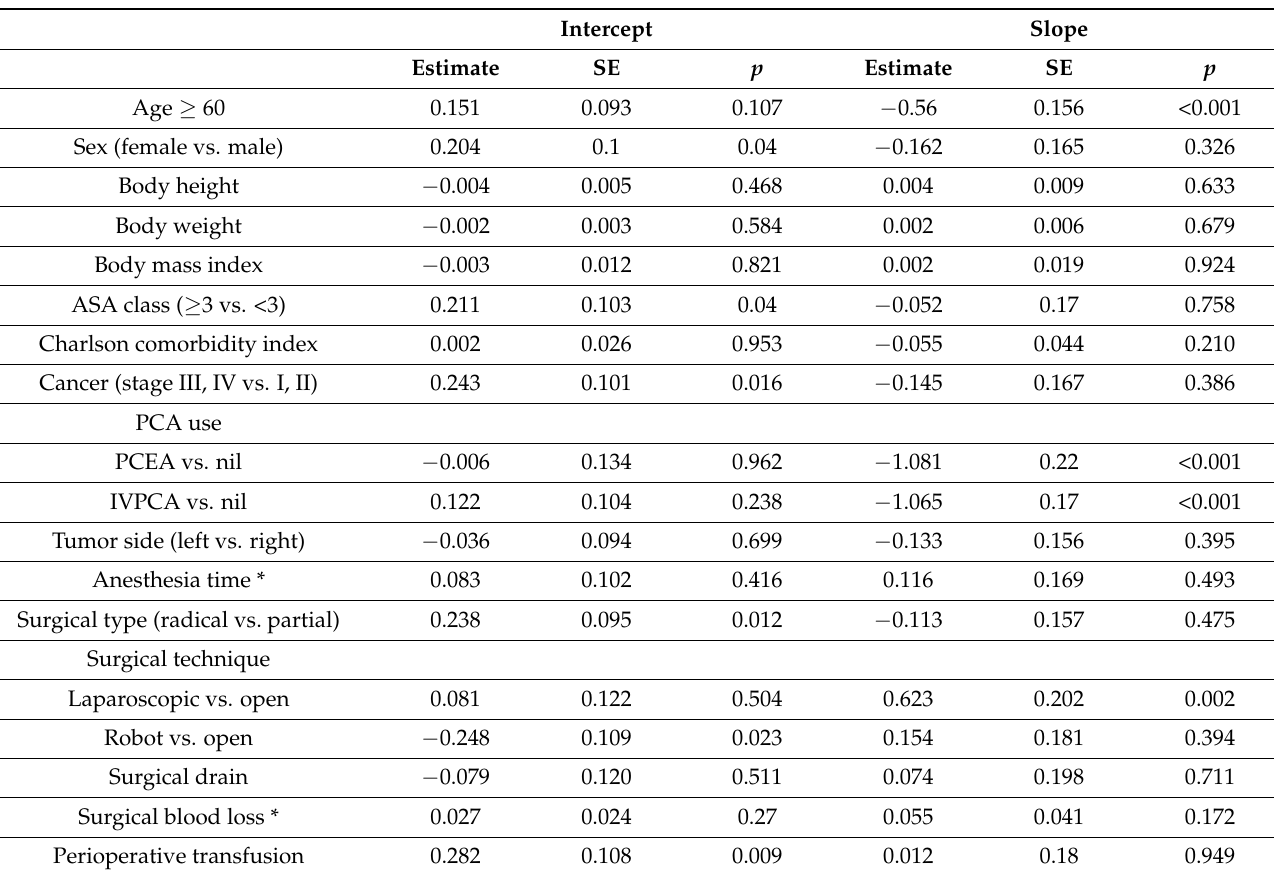
Table 2. Effects of collected variables on the intercept and slope parameters in the single predic- tor model. Intercept Slope